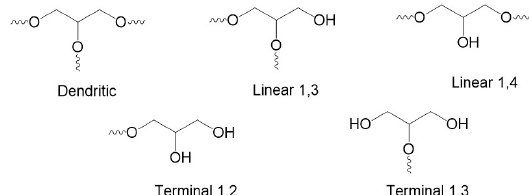
Figure 3. Structural variations of glycerol carbonate monomer